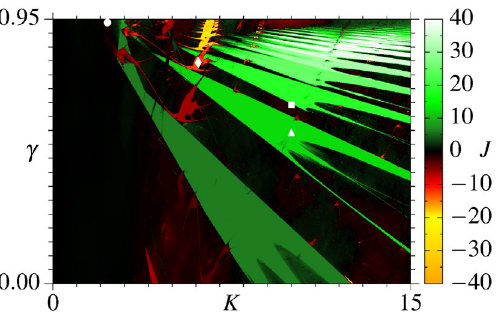
Figure 1. Ratchet current J in the parameter space of the uncoupled case ( β = 0 ) for the coupled ratchets model (1). The parameters are in the intervals γ ∈ [0.0, 0.95] and K ∈ [0.0, 15.0] and the iteration time is 10 6 for 128 initial